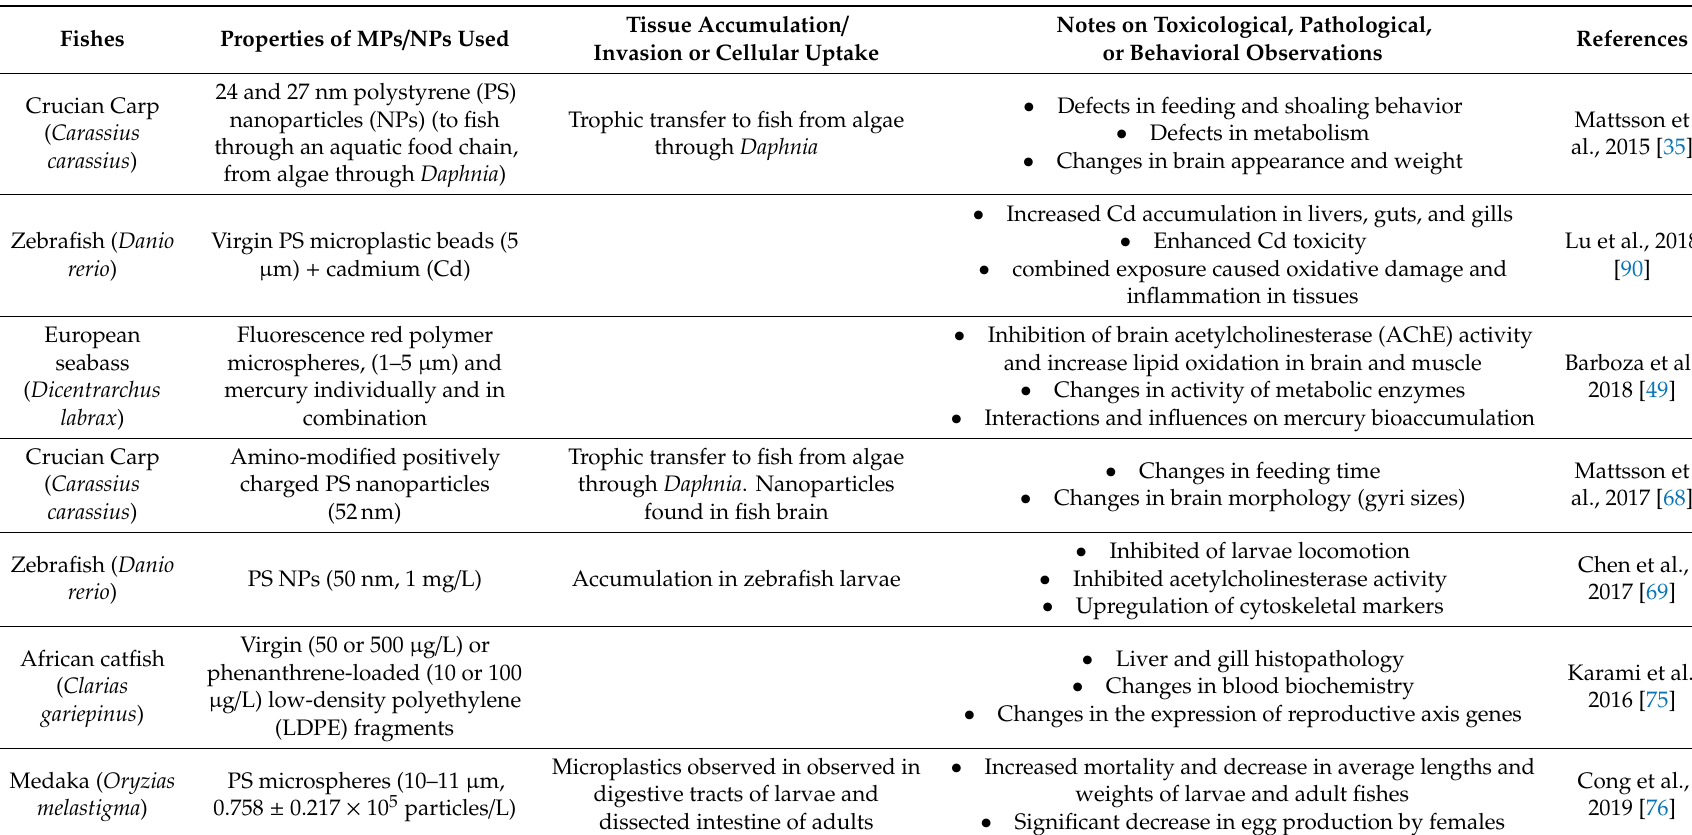
Table 1. A summary of notable toxicological and / or pathological findings associated with MPs / NPs in fishes. PA, polyamide; PS, polystyrene; PE, polyethylene; PC, polycarbonate; PP, polypropylene; PVC, polyvinylchloride; NPs, nanoplastics ( < 1 µ m); MPs,